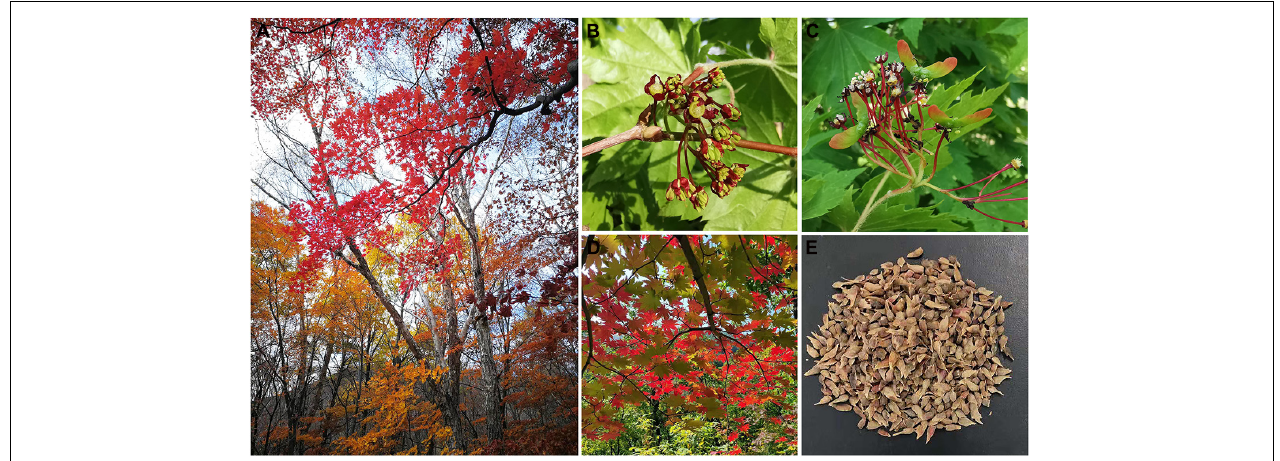
FIGURE 1 | Photographs of Acer pseudosieboldianum . (A) Adult tree, (B) flower, (C) fruit, (D) leaf, and (E) seed.